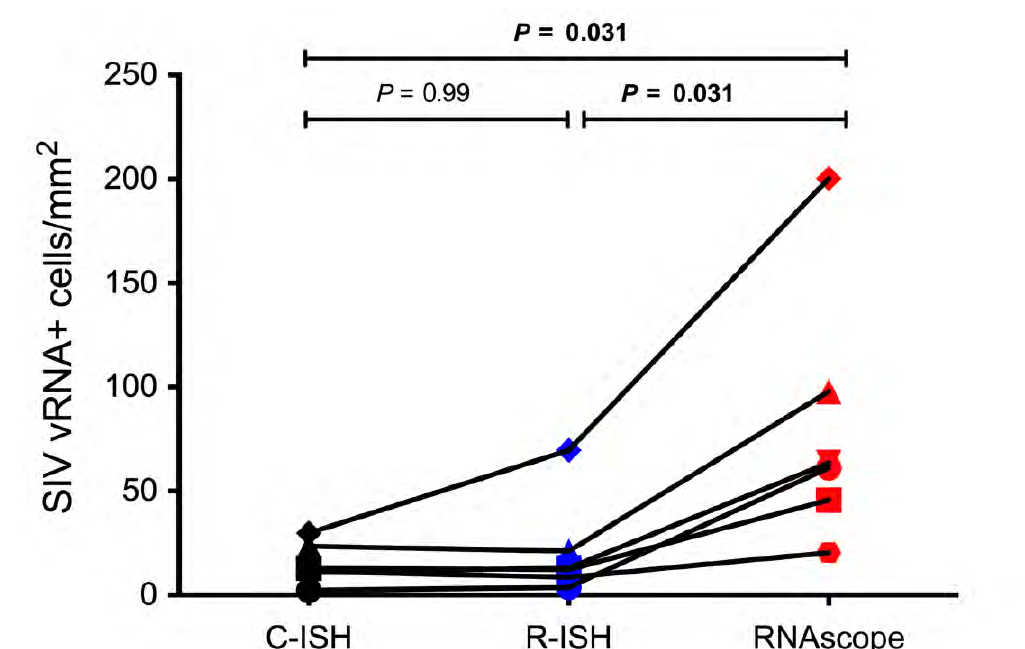
Figure 1. Increased sensitivity to detect vRNA by the next-generation RNAscope approach compared to standard in situ hybridization (ISH) approaches. (A) Schematic to demonstrate key differences between standard radiolabeled ISH (R-ISH), chromogenic ISH (C-ISH) and the next-generation RNA- scope approaches, with cartoon representation of a productively infected vRNA+ cell on the left and virion trapped on FDCs on the right. Comparison between the gold-standard R-ISH, C-ISH, and RNAscope ISH techniques at low (B) and high magnification (C) demonstrating the exquisite sensitivity with potential for detection of virions in tissues. Scale bars = 200 µm. (D) Quantitative image analysis of subjacent lymph node sections from 6 chronically infected SIV+ RMs demonstrating a trend for increased sensitivity of RNAscope for detecting vRNA+ cells. P values were based on the Wilcoxon-sign rank test corrected for multiple